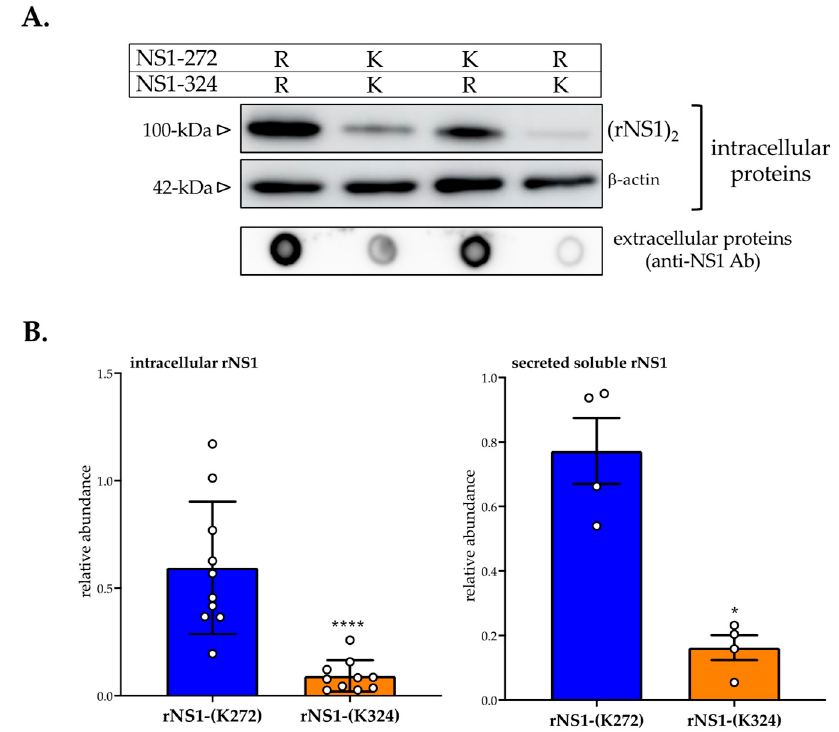
Figure 2. Effects of amino-acid substitutions R272K and R324K on DENV-2 rNS1 expression. Huh7 cells were transfected for 24 h with plasmids expressing DENV-2 rNS1 wt or rNS1-(K272), rNS1-(K324), and rNS1-(K272, K324) mutants. In ( A ), immunoblot assay was performed on non-heated RIPA cell lysates (intracellular proteins) and cell supernatants (extracellular proteins) using anti-NS1 antibody D/2/D6/B7 (anti-NS1 Ab). The intracellular NS1 dimer is indicated as (rNS1) 2 . The β -actin protein served as a protein loading control. The estimated apparent molecular weights of (rNS1) 2 and β -actin are indicated. The basic residues at the positions NS1-272 and NS1-324 are shown at the top. In ( B ), signal intensity was quantified using ImageJ software to evaluate the amount of rNS1 mutants relative to rNS1 wt . The results are the mean (± SEM) of 10 (intracellular rNS1) or 4 (secreted rNS1) replicates (open circles). p -values were determined on the comparison of rNS1-(K324) with rNS1-(K272) mutant (**** p < 0.0001; * p < 0.05).